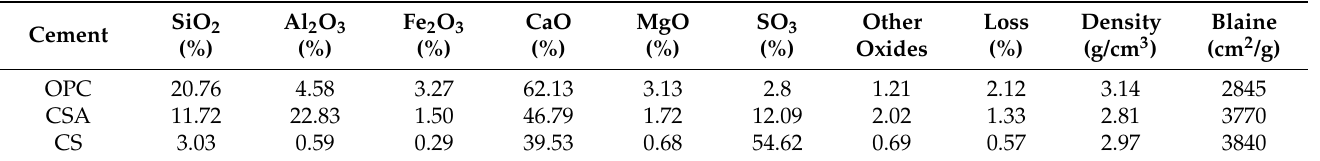
Table 1. Chemical compositions and physical properties of cementitious materials.